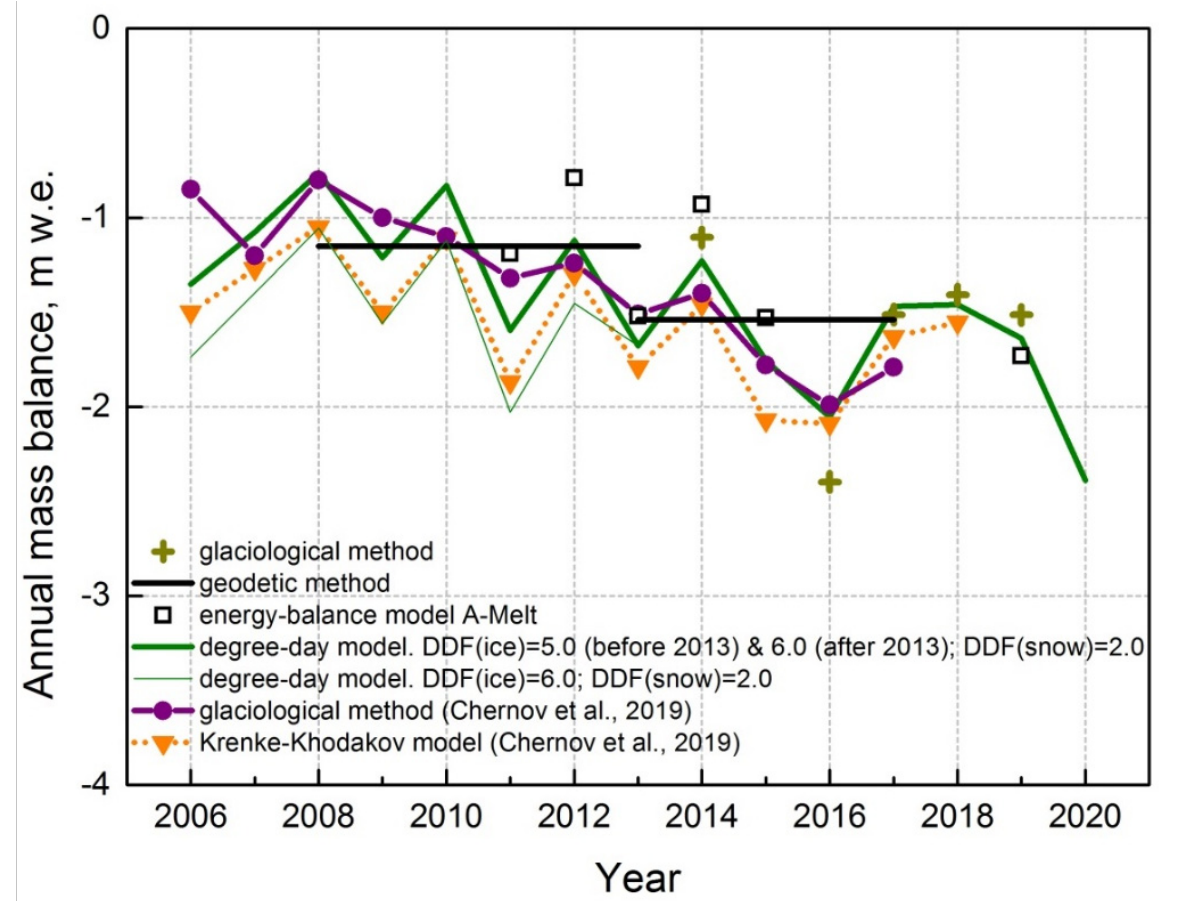
Figure 11. Mass balance estimates by different methods from this study and Chernov et al . [15].